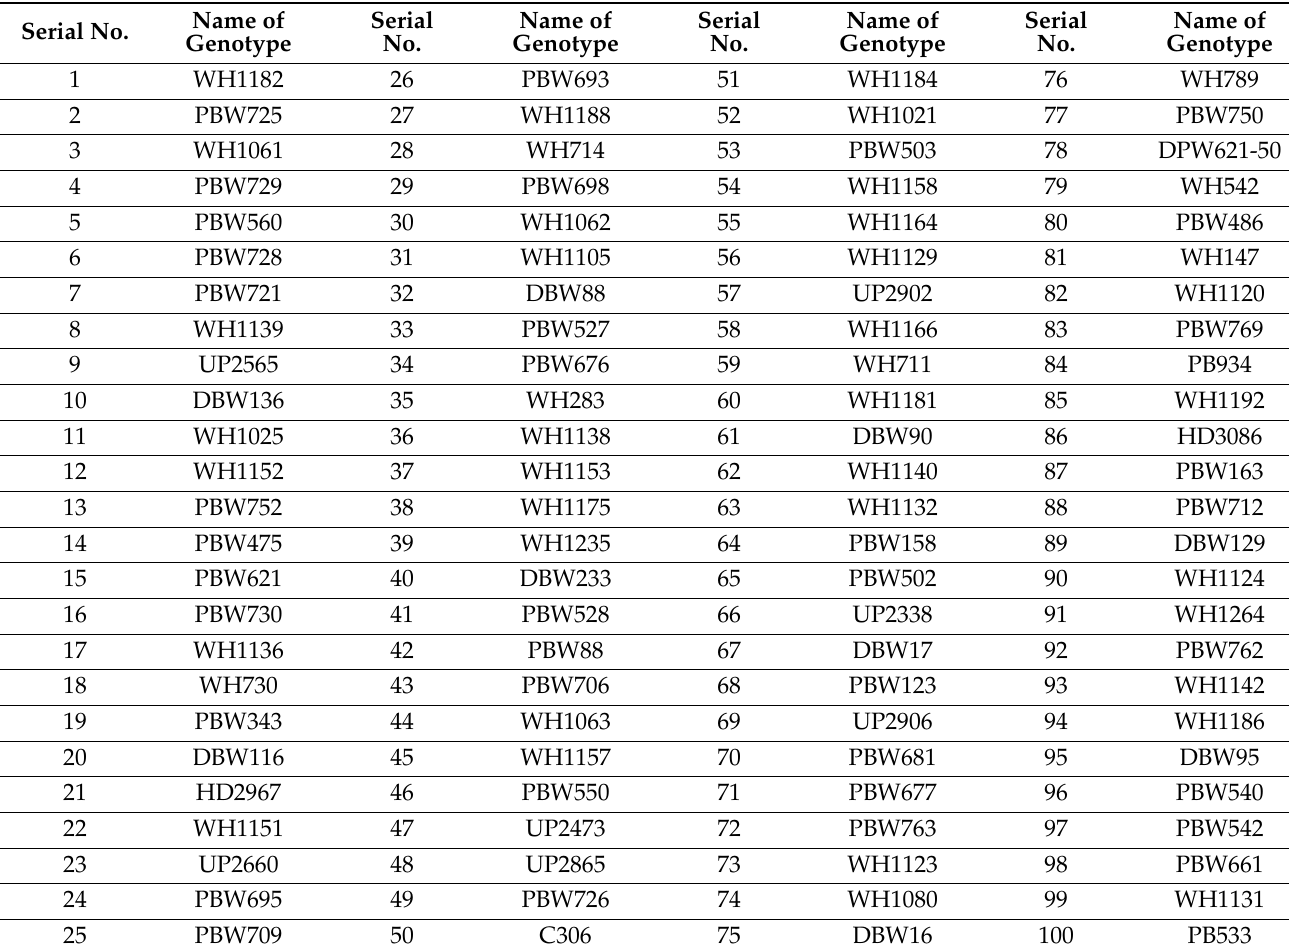
Table 2. List of 100 bread wheat genotypes used in the present